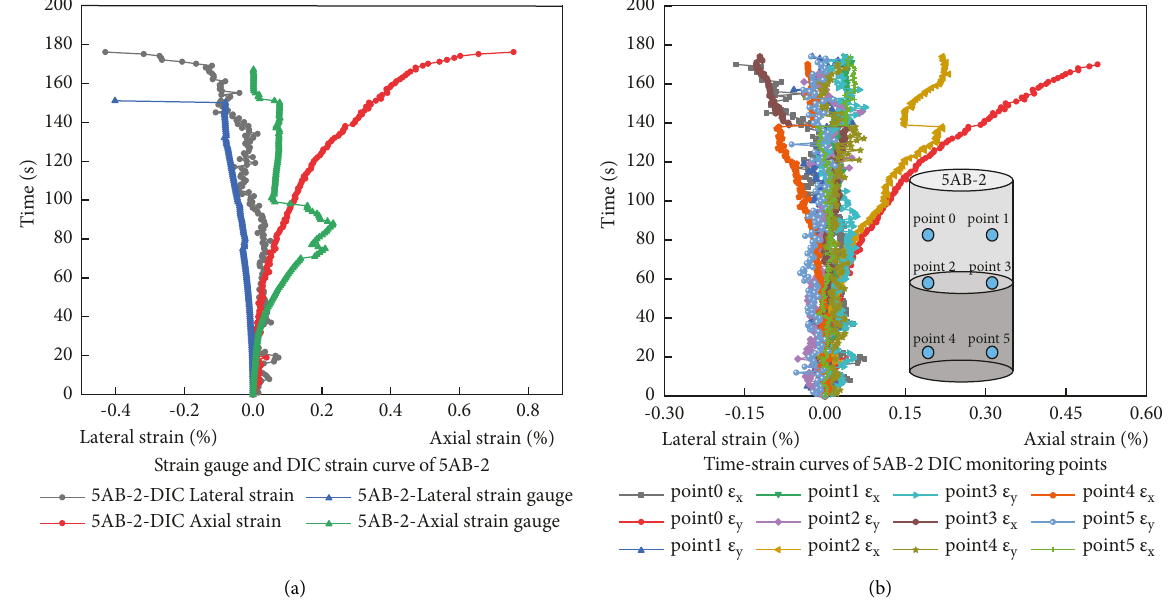
Figure 12: Time-strain curve of 5AB-2. (a) Strain gauge and DIC strain curve of 5AB-2. (b) Time-strain curves of 5AB-2 DIC monitoring